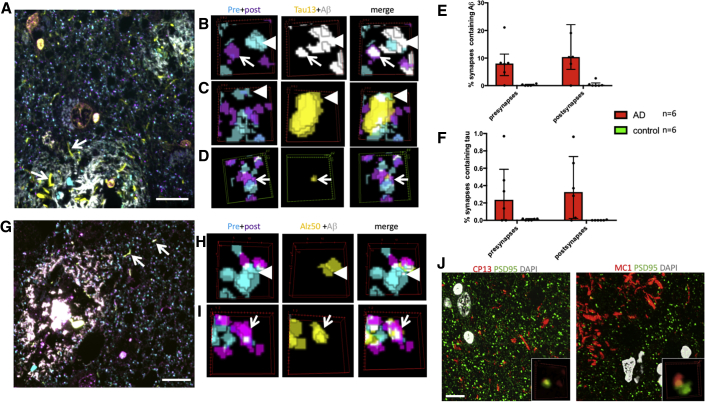
Tau Is Found in Pre- and Postsynapses in Human AD Brain(A–F) Array tomography was used in human AD and control postmortem brain tissue to stain Aβ (white), Tau13 (yellow), PSD95 (magenta), and synaptophysin (cyan). Tau13 stains neuropil threads (A, arrows). Examining individual synapses revealed that Aβ was present in 8.0% of presynaptic terminals (B, arrowheads) and 10.4% of postsynaptic densities (B, arrows) near plaques in AD cases (B and E). Tau13 staining was observed in 0.23% of presynaptic terminals (C, arrowheads, quantified in F), and 0.32% of postsynaptic terminals (D, arrows, quantified in F).(G–I) Misfolded tau labeled with Alz50 (yellow) was observed in neuropil threads (G, arrows) and in presynapses (H, arrowheads) and postsynapses (I, arrows).(J) Tau phosphorylated at serine 202 (labeled with CP13) and misfolded (residues 5–15 near 312–322, labeled with MC1) was observed in PSDs.Images in (A) and (G) and large panels in (J) are maximum intensity projections of 10 serial sections. Scale bar represents 10 μm in (A), (G), and (J). (B)–(D), (H), (I), and insets in (J) show three-dimensional reconstructions of a 2 × 2 micron region of interest in 5 consecutive serial 70-nm sections. Data shown are median and interquartile ranges. Each dot represents the median of a single human subject (subject is the biological replicate/experimental unit, n = 6 per group). See also Table S4.